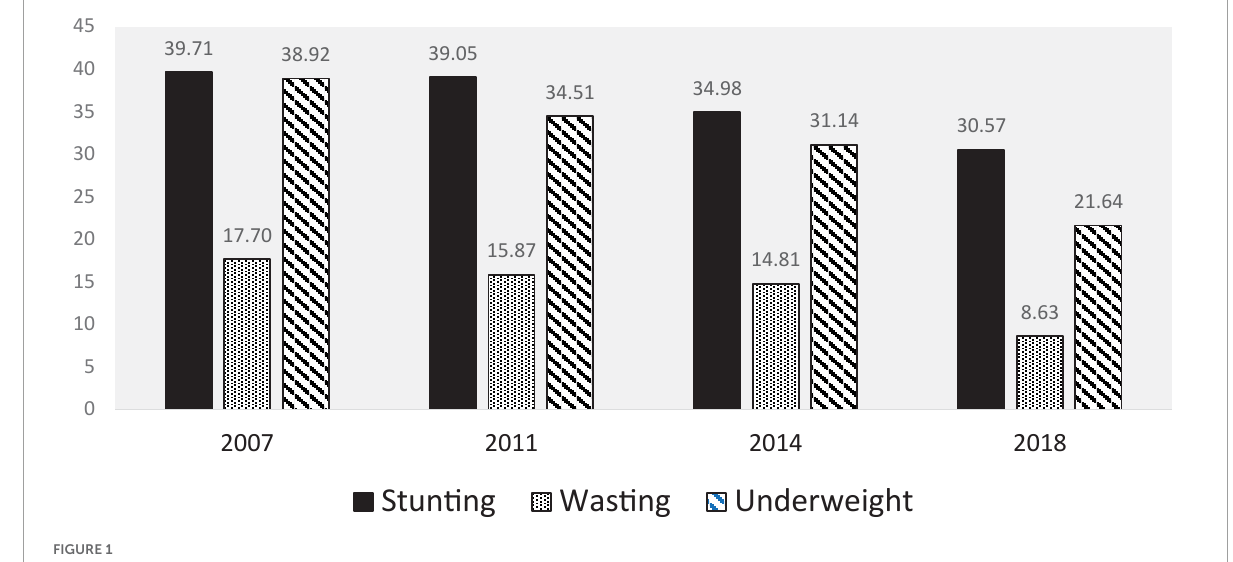
We have compared the common predictors of undernutrition in Table 3 across the geographical